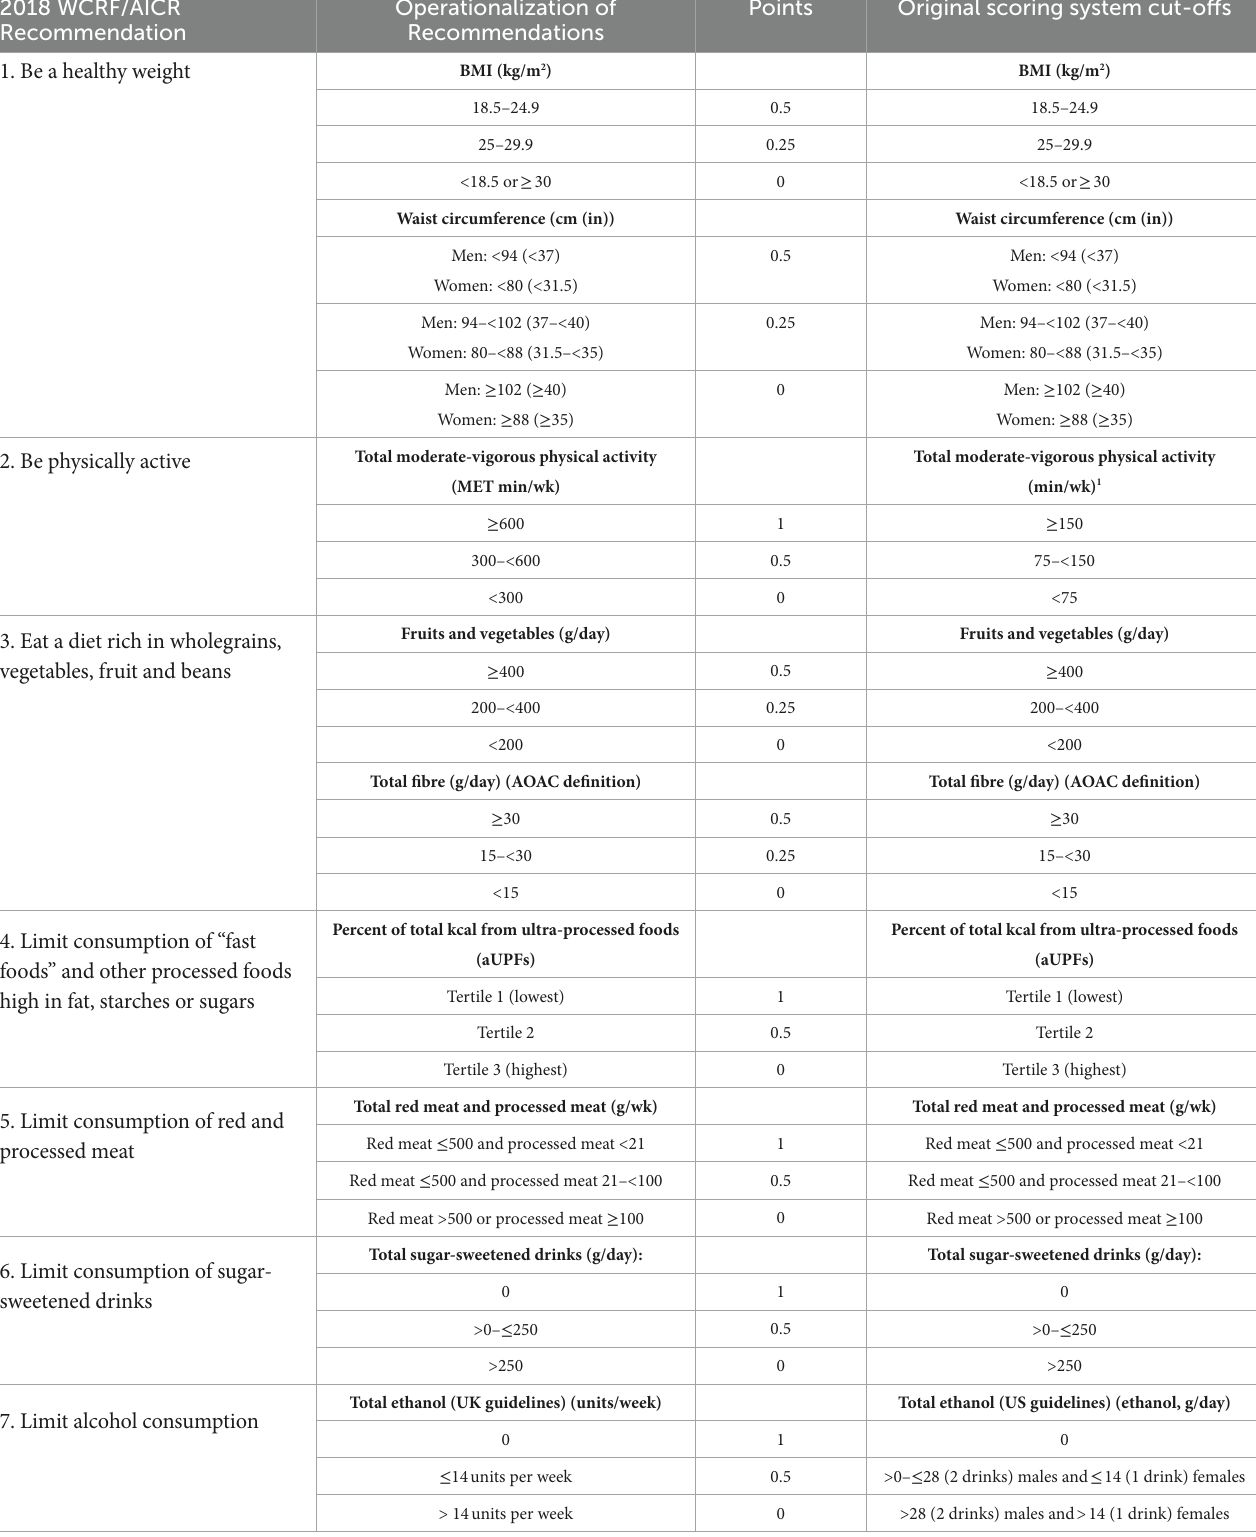
TABLE 1 Standardised scoring system used to assess adherence to the 2018 WCRF/AICR Cancer Prevention Recommendations, as devised by Shams-White et al.